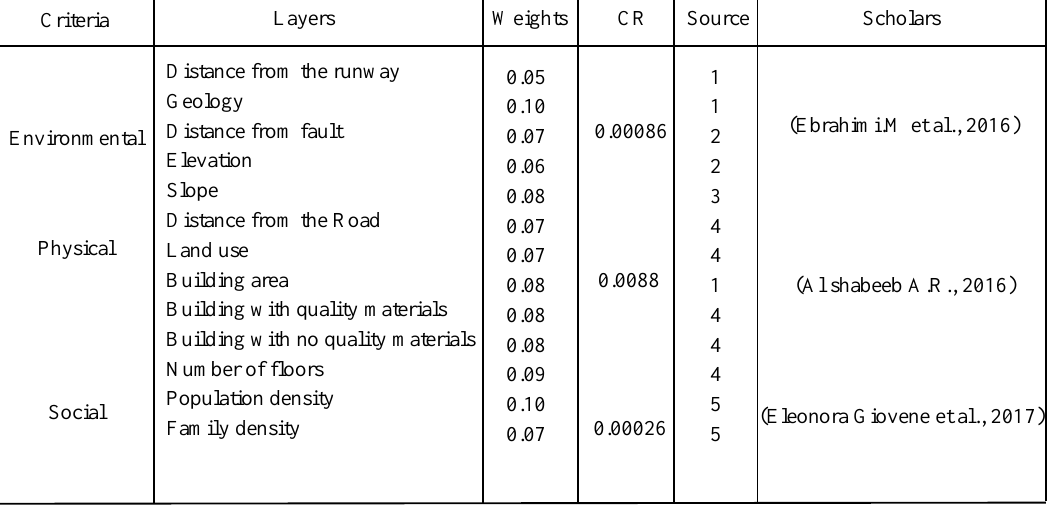
Table 1. Weights for Criteria and Layers based on the AHP model